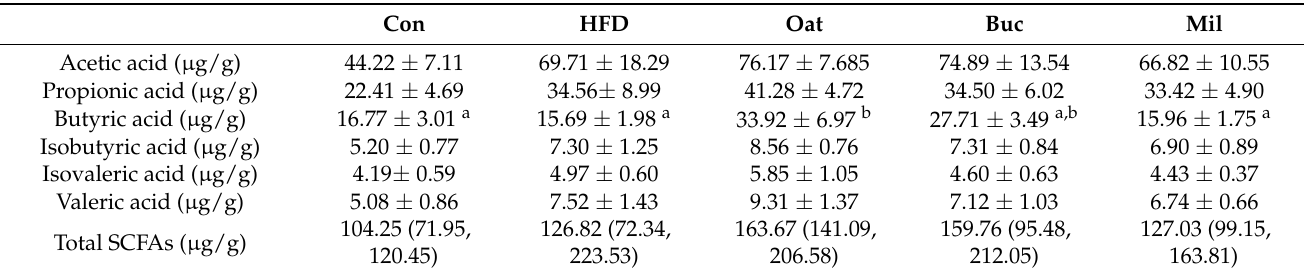
Table 2. Effects of oats, tartary buckwheat, and foxtail millet supplementation on SCFAs in colonic contents of rats at the end of 12